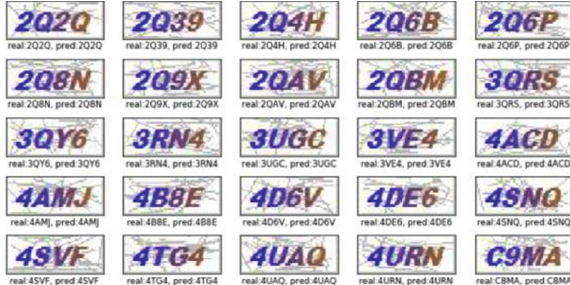
Figure 10: Recognition results on CNKI.